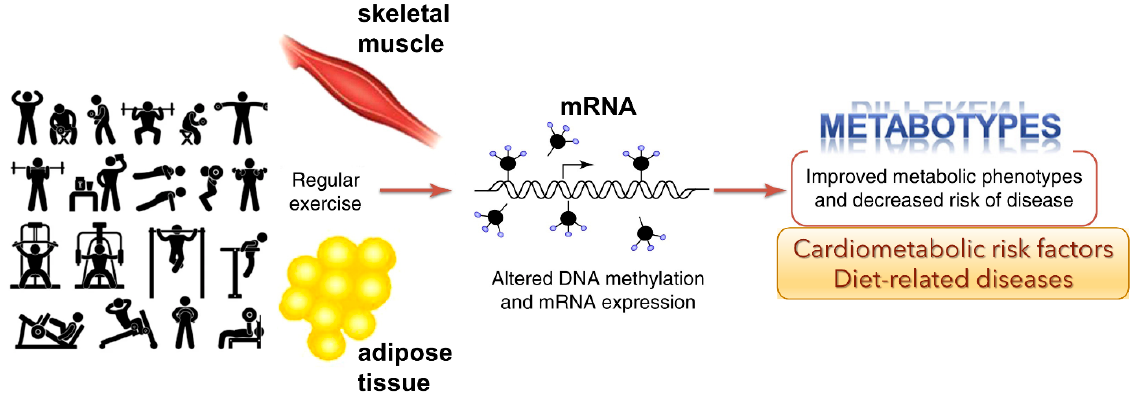
Figure 3. Genome ‐ wide epigenetic modifications in human skeletal muscle and adipose tissue due to regular exercise is linked to DNA methylation and altered mRNA expression (adapted from Ling and R ō nn (2014) [45]). This could potentially improve metabolic phenotypes and decrease the risk of disease.